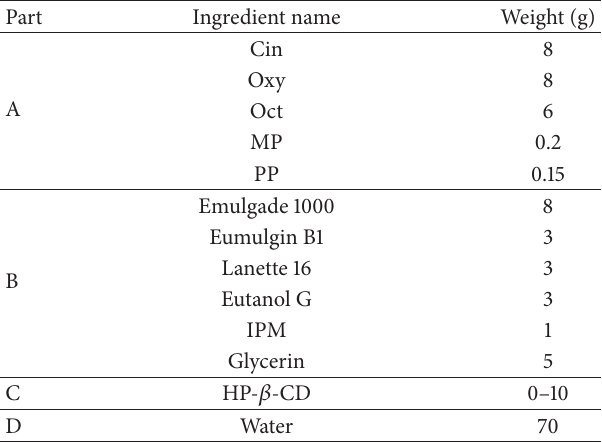
Table 1: Sunscreen lotion SPF 30 formula